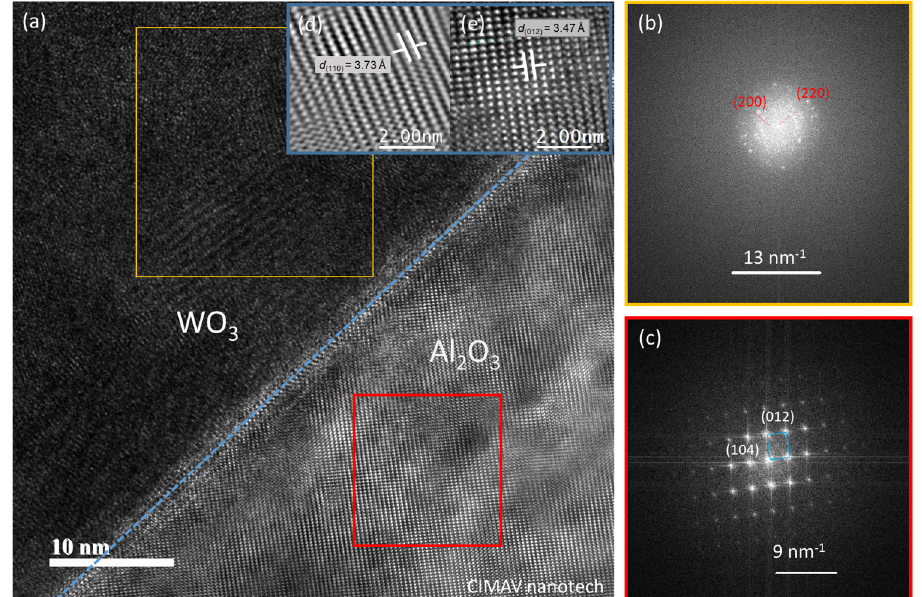
Figure 3. ( a ) High-resolution Cs-corrected TEM images. A selected area electron diffraction pattern of ( b ) WO 3 thin film corresponding to a polycrystalline structure, including a tetragonal (P4/nmm) structure, and of ( c ) the sapphire substrate with monocrystal of an Rc3 structure. Atomic arrays of ( d ) film and ( e ) substrate structures, with lattice plane distances of d (110) = 3.74 Å and d (012) = 3.47 Å, respectively.